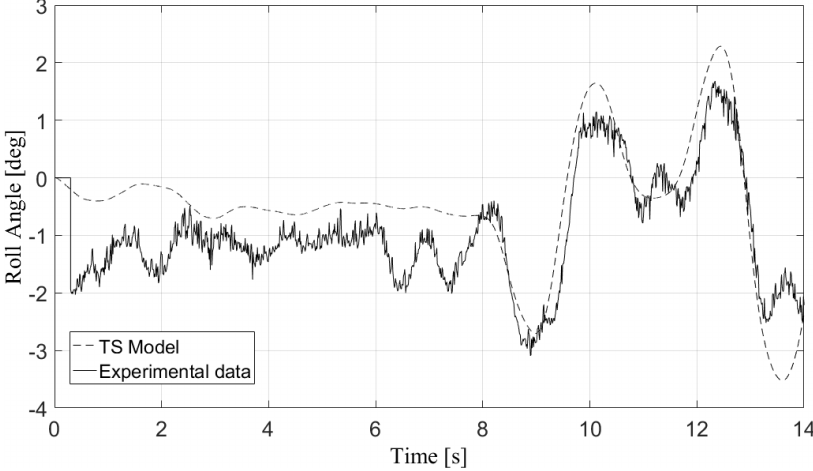
Figure 3. Validation of the vehicle simulation model for a double change lane